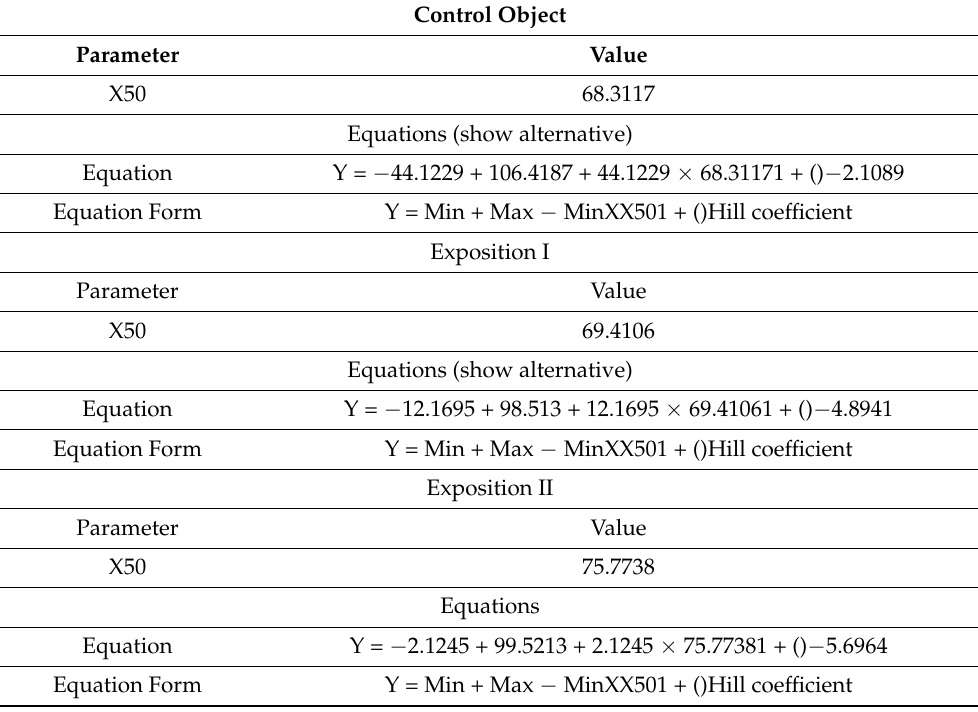
Table 2. Boltzmann regression results for the germination rate of common bean